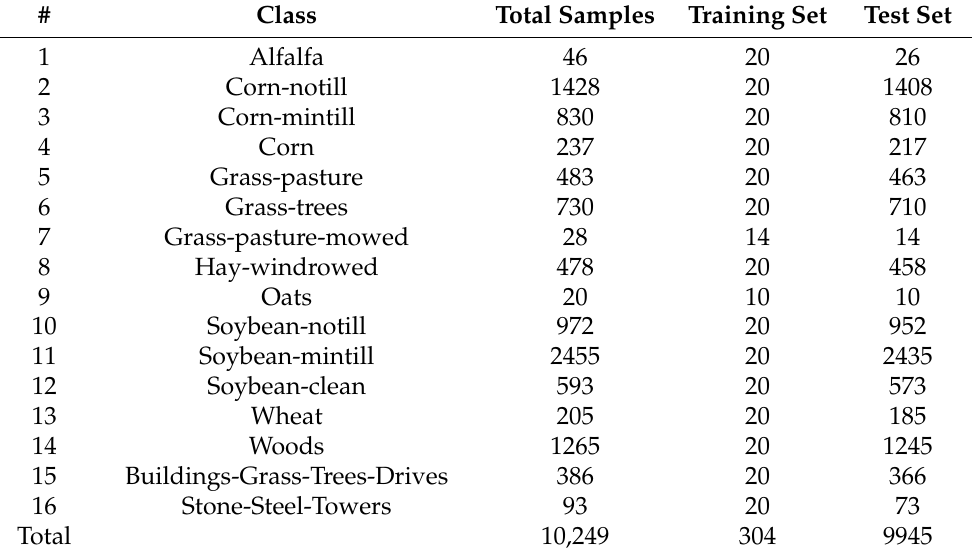
Table 1. The number of samples in each category in the Indian Pines